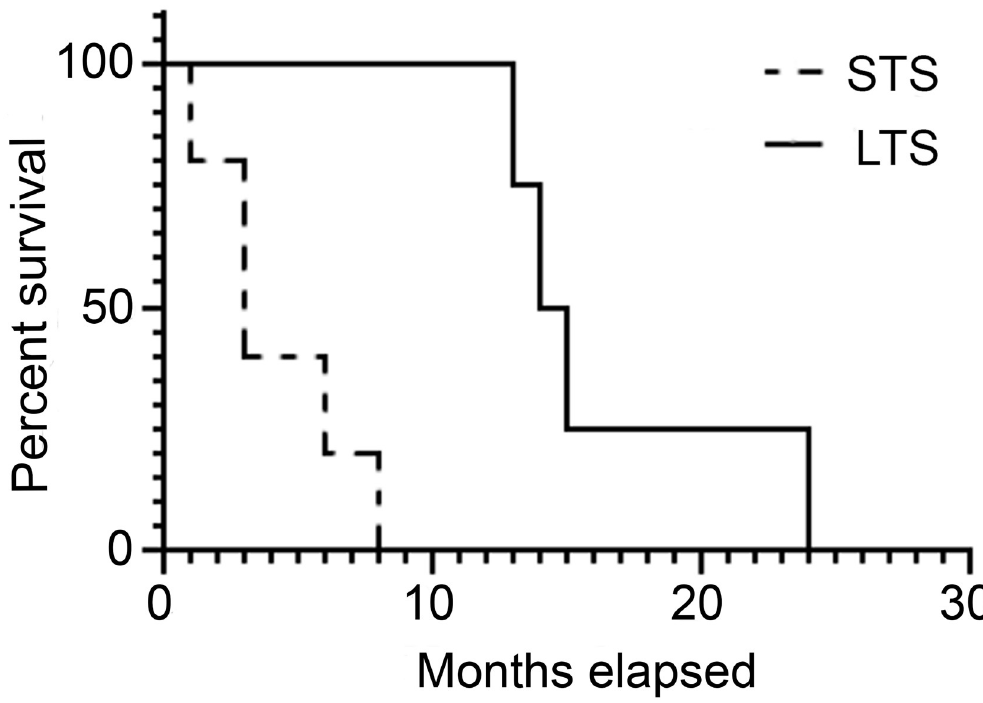
Fig 1. Overall survival of patients with short-term survival (STS) (less than 12 months after surgery) and long-term survival (STS) (more than 12 months after